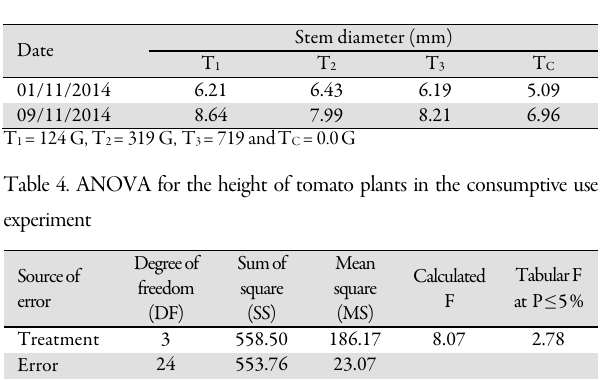
Table 3. Mean diameter of the tomato stems, measured 30 mm above the soil level